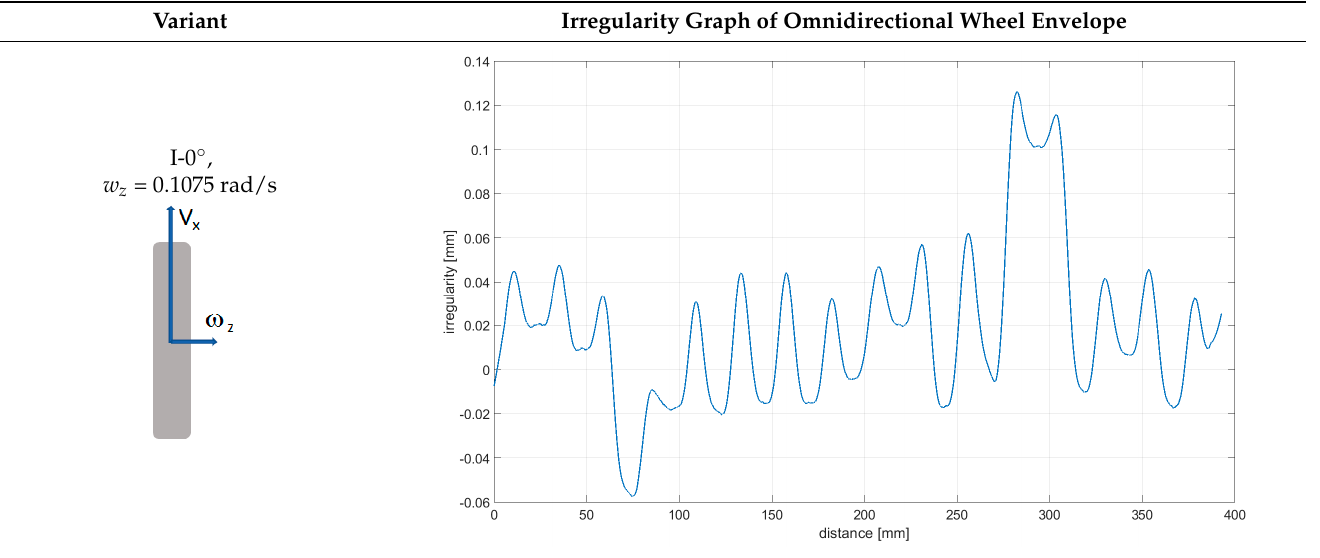
Table 3. Irregularity of the omnidirectional wheel envelope. ω z , wheel angular speed (rad/s). Variant